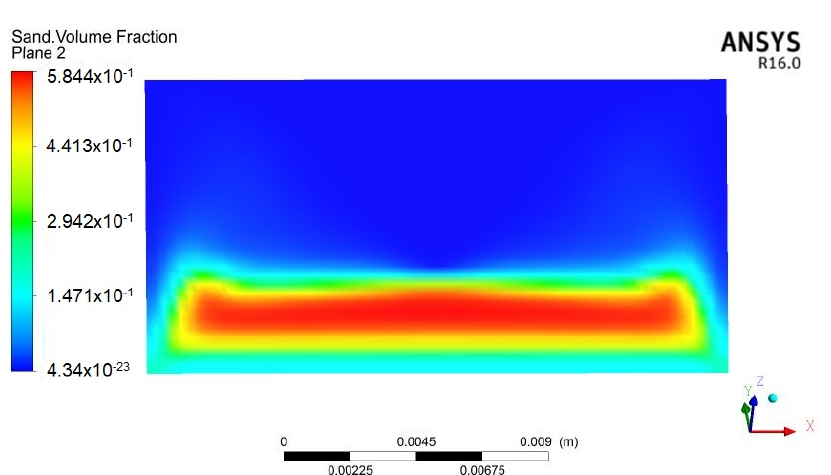
Figure 6. Sand volume fraction at plane 2.